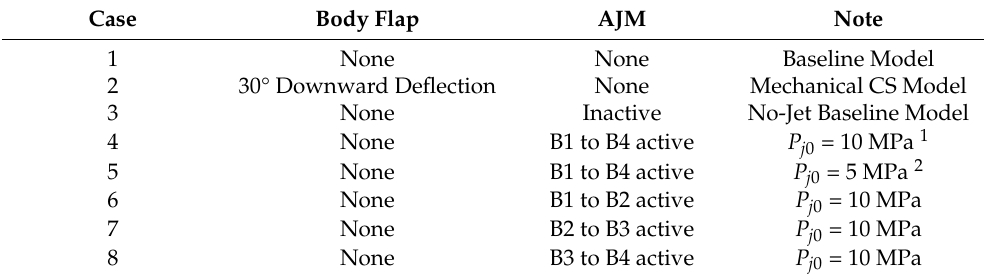
Table 1. Computational Cases and